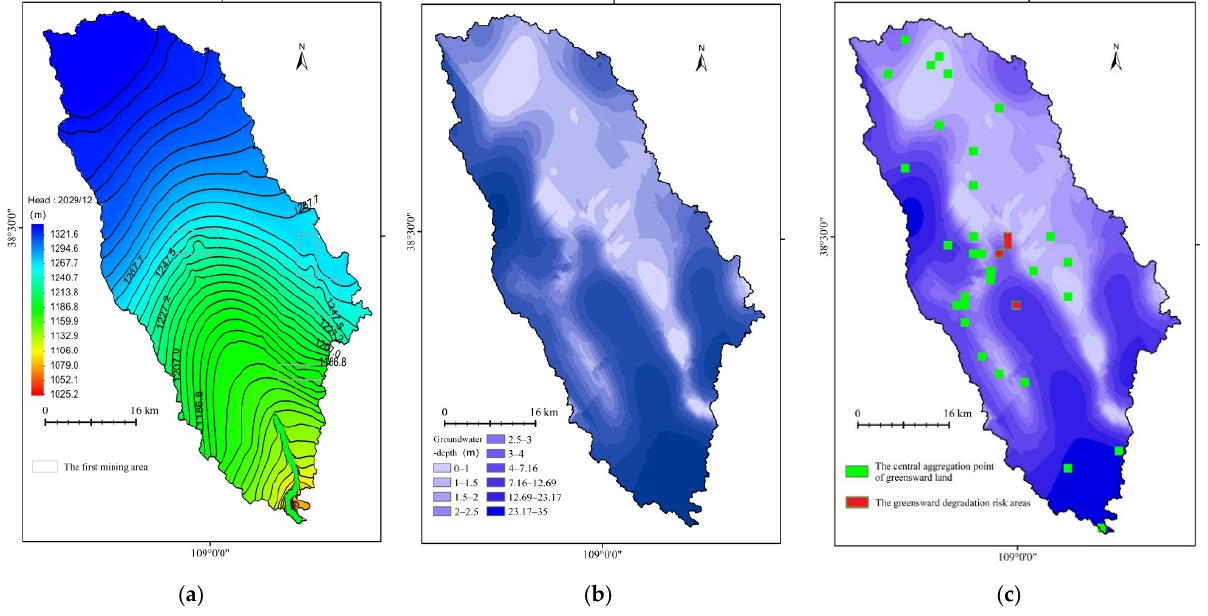
Figure 10. ( a ) Groundwater simulation flow field in the watershed; ( b ) Interpolation of simulated groundwater depth in the watershed; ( c ) Location of greensward aggregation centers in the watershed (colors of the groundwater flow field are illuminated for contrast).